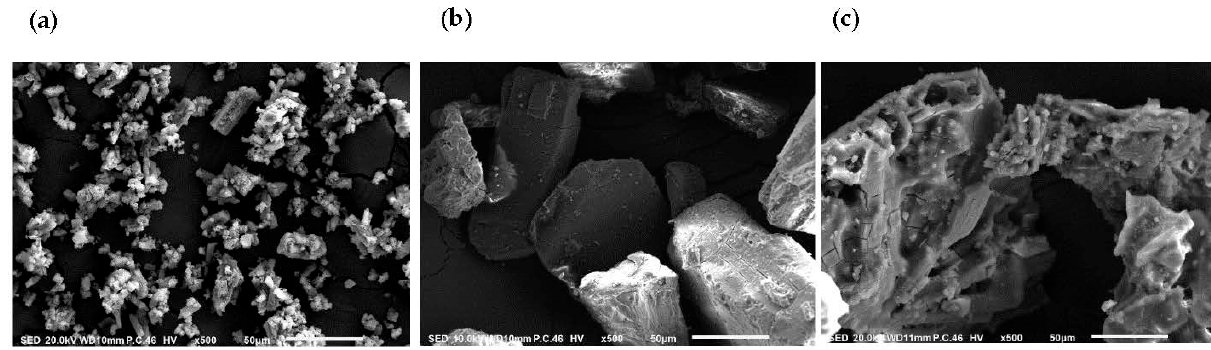
Figure 2. Scanning electron microscopy photomicrographs of ( a ) CUR, ( b ) β CD, and ( c ) β CD-CUR. The scale bars at 500× magnification were shown.